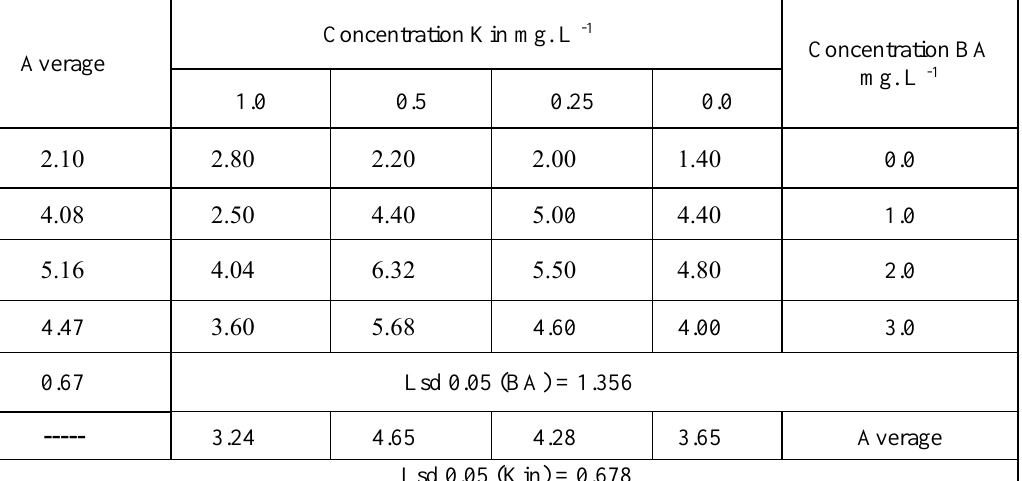
Table 1. The effect of BA and Kin and their interaction on the mean number shoot of stevia in vitro after four weeks of